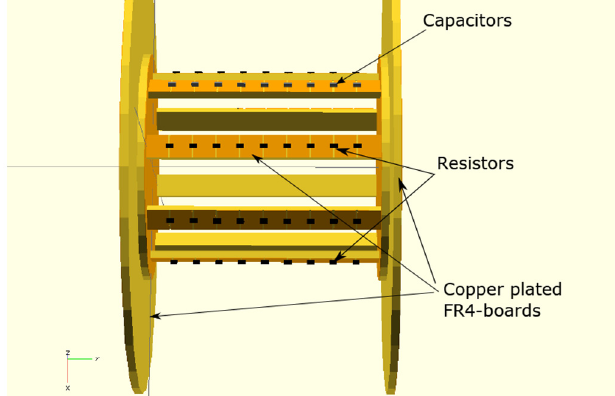
Fig. 3. Simpli fi ed model of the Voltage Divider ’ s inner body. The black and grey prisms respectively represent 1.4k V resistors and 330